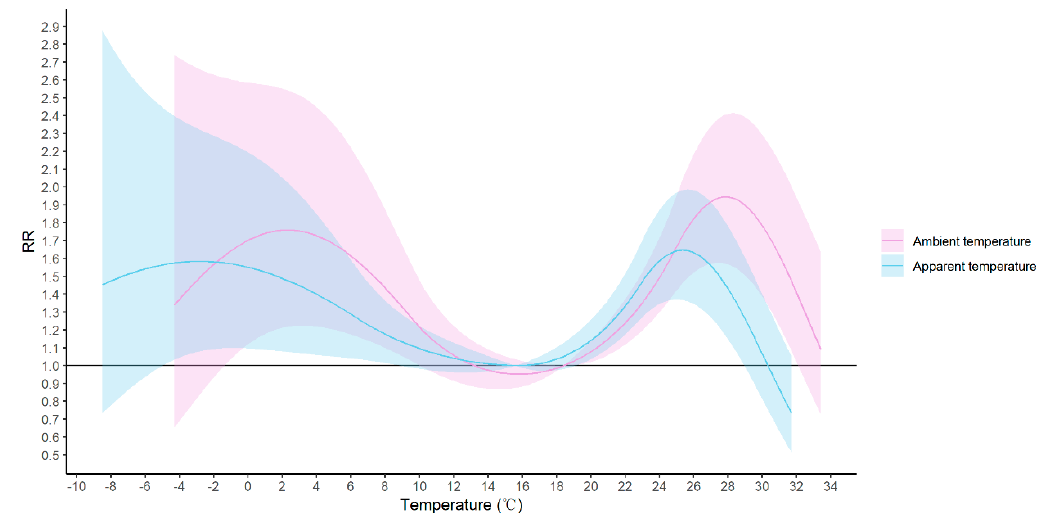
Figure 5. Cumulative effects of ambient temperature and apparent temperature on the incidence of HFMD. The medium value of each variable was selected as the reference.